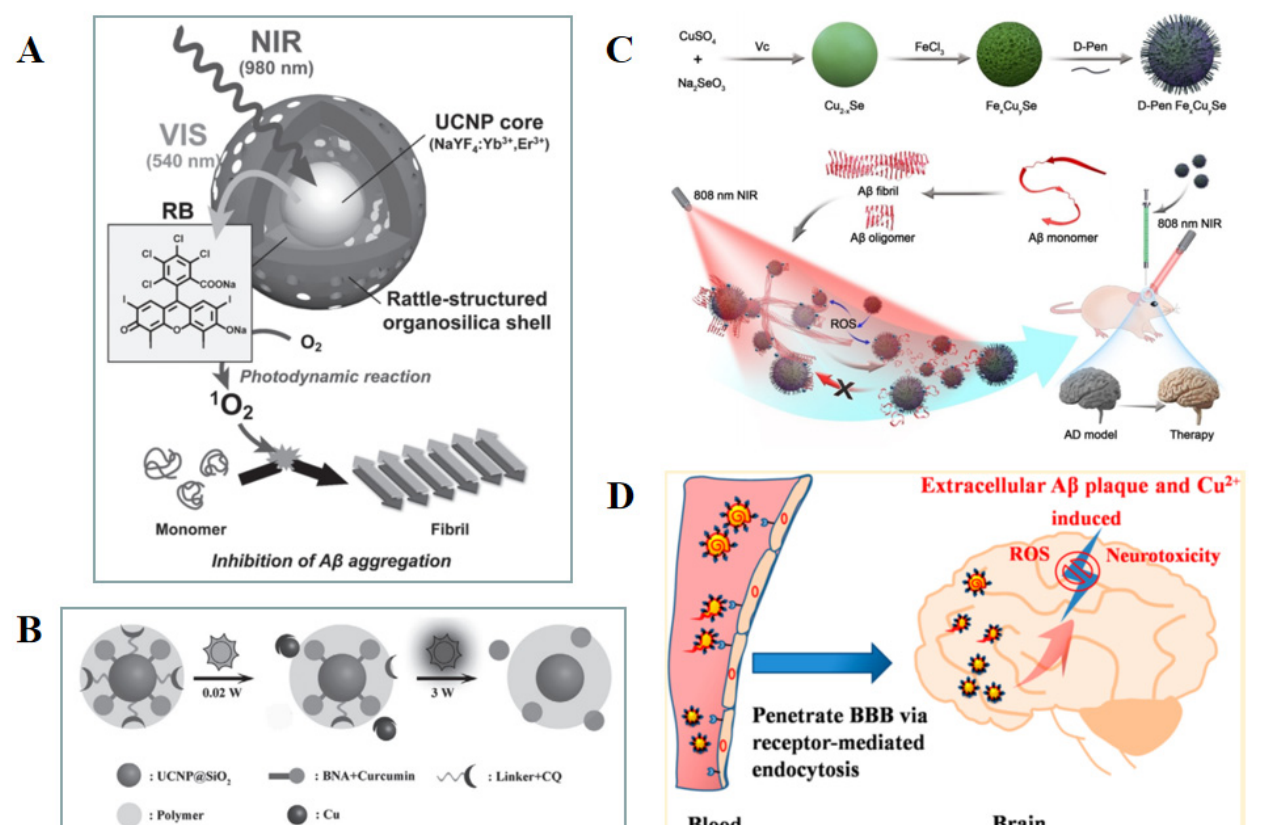
Figure 15. ( A ) Schematic of A β aggregation inhibition by NIR-responsive rattle-structured UCNPs. Reprinted with permission from reference [194]. Copyright 2017 Wiley-VCH. ( B ) Illustration of agents that are sequentially released during a process based on 980 nm NIR light-triggered UCNP@SiO 2 @Cur/CQ. Reprinted with permission from reference [195].